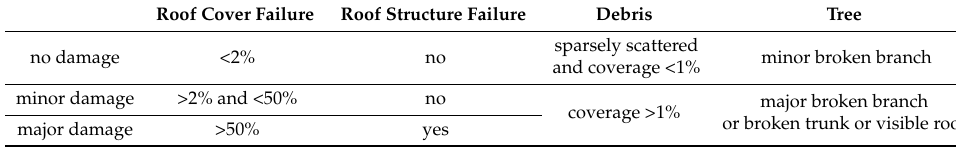
Table 1. Annotation rubric for